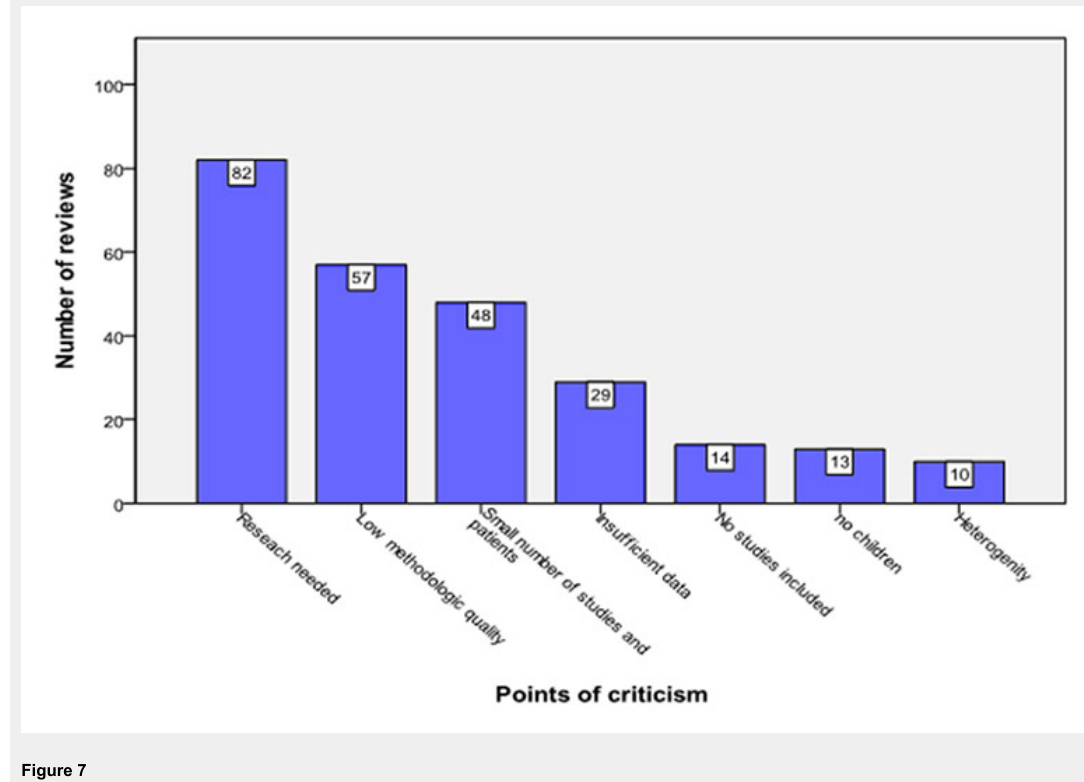
Figure 7 Most common criticisms in Cochrane